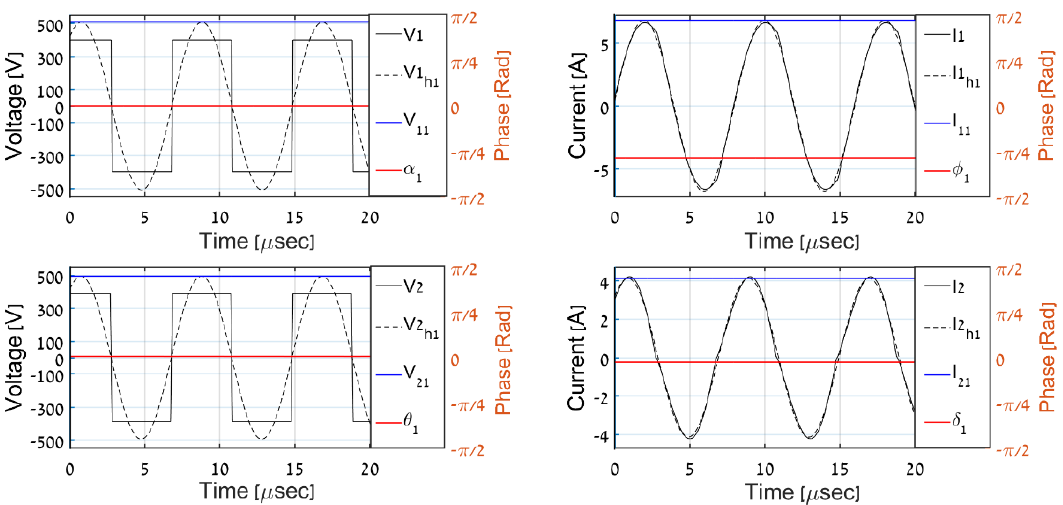
Figure 8. Simulation results, P O = 1000 W.